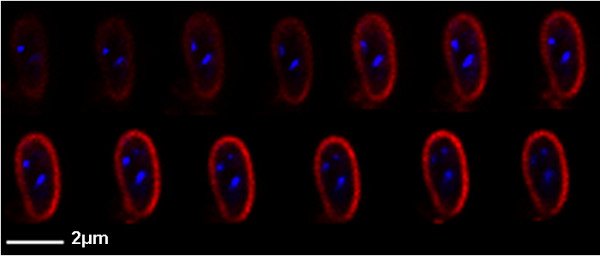
Optical sections of a Rubrobacter radiotolerans cell. The series is in order from left to right of the images within a row and from top to bottom of the rows within the figure. Images are taken at 100 nm intervals.